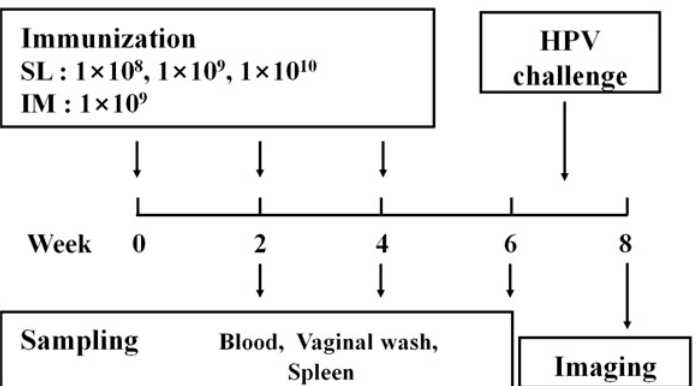
Fig 2. SL and IM immunization and sampling schedules. All mice were given three immunizations at 2- week intervals via the SL or IM route. Serum and vaginal secretion samples were collected 2, 4, and 6 weeks after the first immunization. Spleens were collected 6 weeks after the first